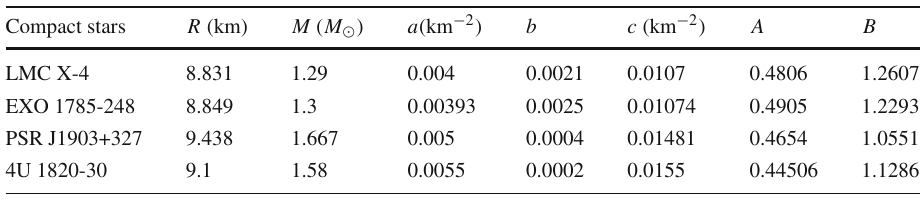
Table 1 Numerical values of physical parameters a , b , c , R (km), M ( M (cid:7) ) for different values of n [30]